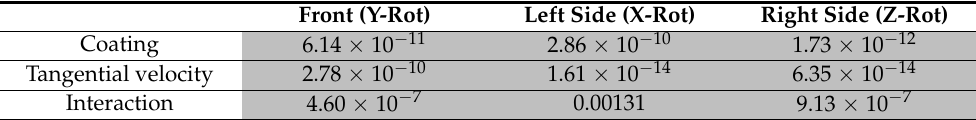
Table 6. Two-way ANOVA results ( p -values) for the BrIC. p -values < 0.05 portrayed as shaded cells. Front